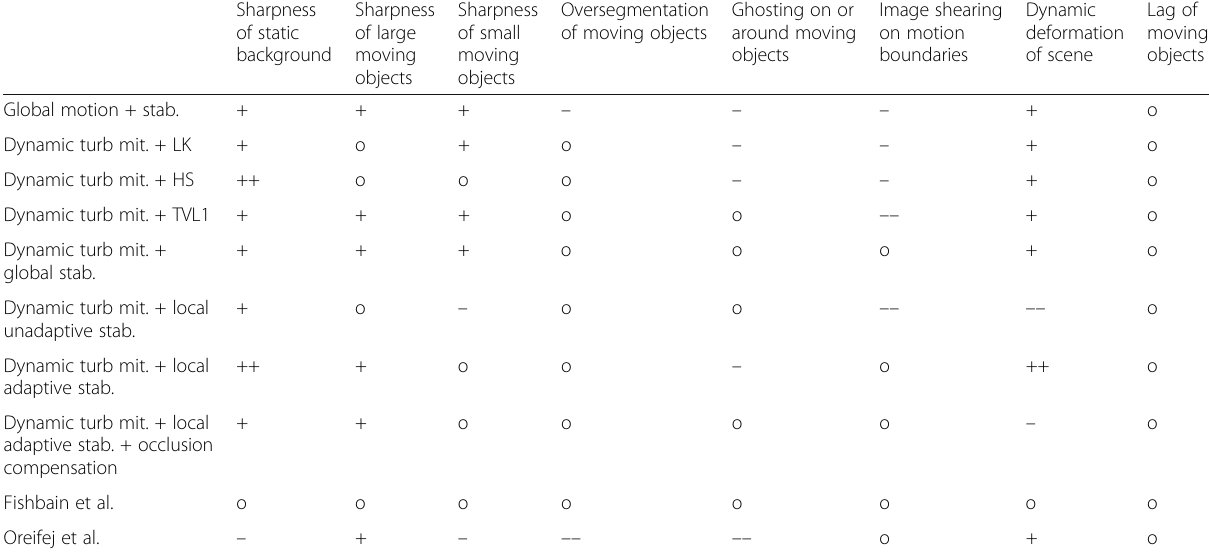
Table 1 Comparison of methods on the main factors determining the image quality. Three independent test subjects scored the performance, in terms of their ability to perceive the scene, relative to the raw input images before mitigation as: large improvement [+ +], improvement [+], no significant improvement or deterioration [o], deterioration [ − ], and large deterioration [ −− ]. High scores on oversegmentation and deformation thus indicate positive contributions to image quality. The results for the different motion estimation methods (LK, HS, TVL1) are reported assuming local adaptive stabilization but not occlusion compensation. The results for dynamic turbulence mitigation with stabilization or occlusion compensation are reported assuming the best performing motion estimation method for a given